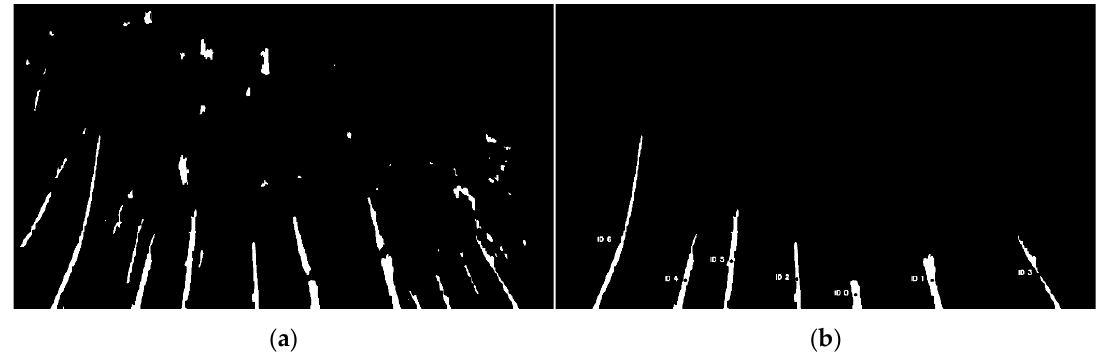
Figure 6. ( a ) Segmentation result after morphological closing was applied; ( b ) Detection procedure output frame.